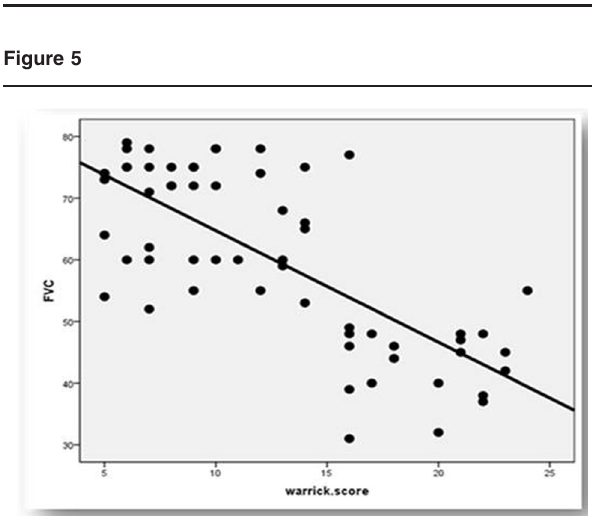
Illustrates the relation between Warrick score and 6MWT. 6MWT, 6min walk test.